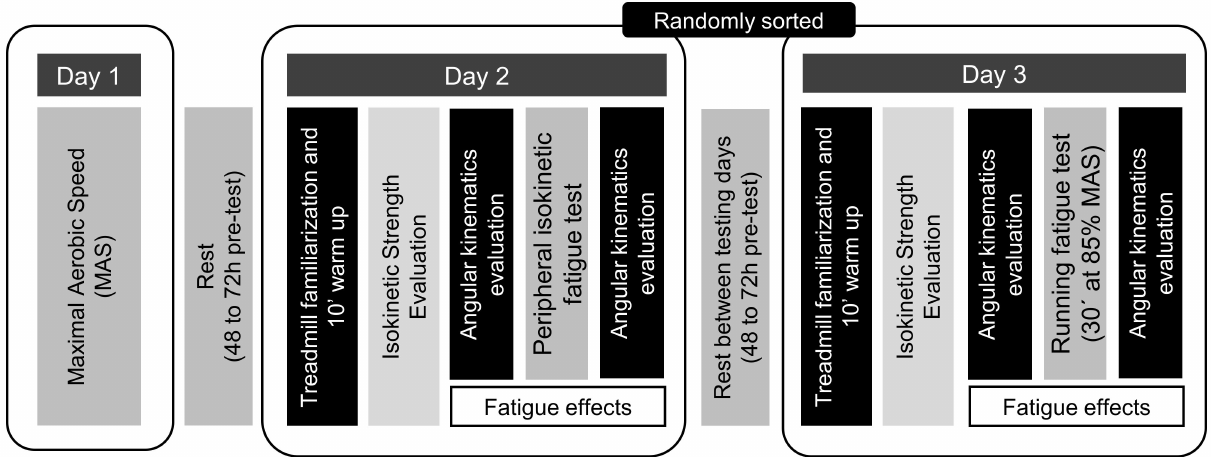
Figure 1. Experimental protocol followed in the